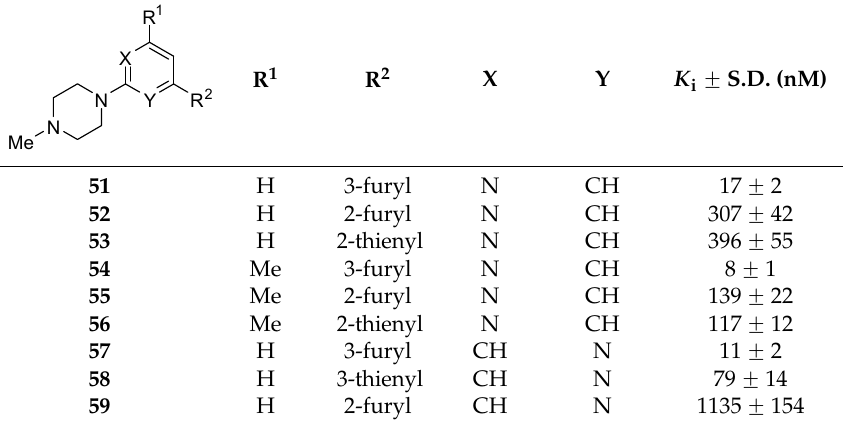
Table 4. Binding affinities of substituted pyridines 51 – 59 for 5-HT 7 receptor (see Schemes 6–8). R 1 X Y R 2 N N Me